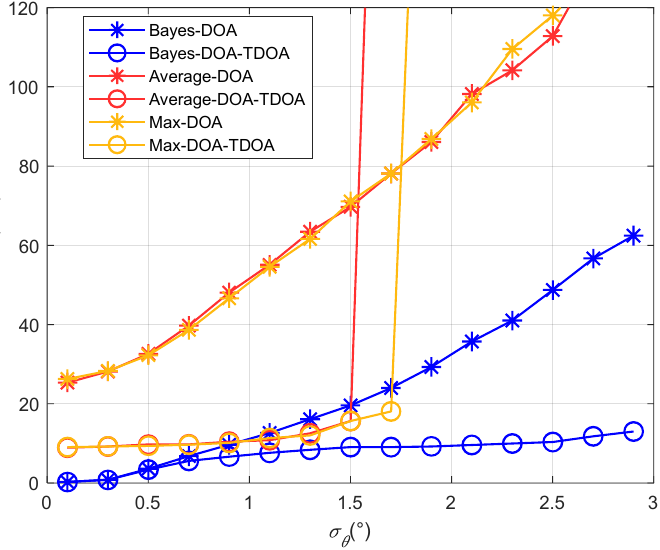
Figure 14. The positioning accuracy varied with the standard deviation of the angle’s error when the multipath elevation angle difference was 1°.